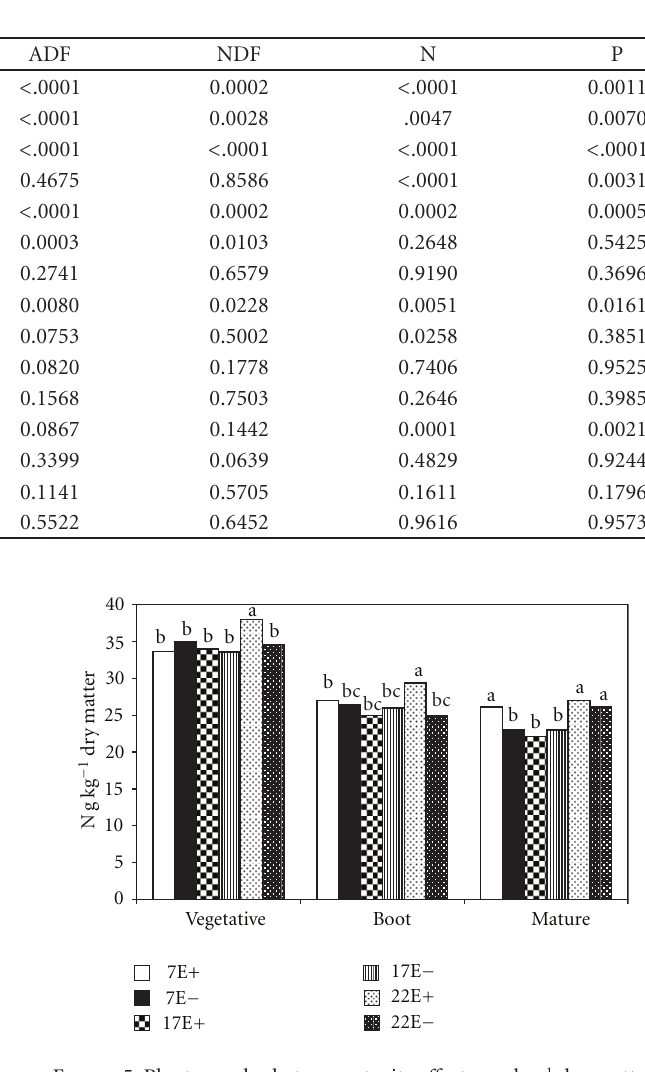
Figure 5: Plant × endophyte × maturity e ff ect on g kg − 1 dry matter N concentrations from the greenhouse. Within maturity, bars with di ff ering letters are significantly di ff erent at P = .